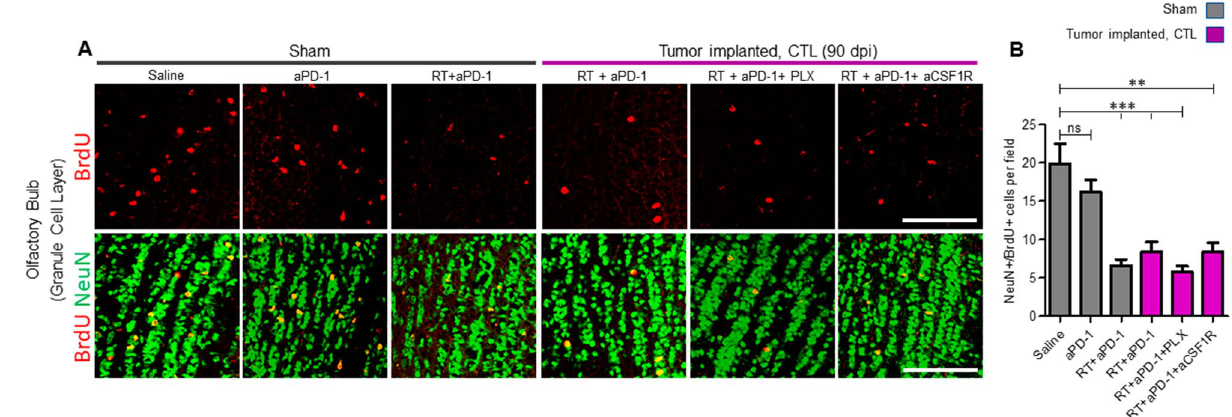
Figure 4. Treatment with RT + aPD-1 decreased the number of adult-born granule cells in the olfactory bulb. ( A ) Sham operated and tumor implanted mice received daily i.p. injections of BrdU starting at 60 dpi until 67 dpi. Coronal sections of the olfactory bulb (OB) from the hemisphere contralateral to the tumor implantation site (CTL) were collected at 90 dpi. Representative images from the granule cell layer (GCL) immunostained with antibodies against BrdU (red) and the neuronal marker NeuN (green) for the indicated experimental groups are shown. Scale bar = 100 µm. ( B ) Quantification of the number of adult-born granule cells (BrdU/ NeuN double positive cells) in the GCL of the OB. n = 3 per group, ** P < 0.01 and *** P < 0.01 by ANOVA followed by Tukey’s post hoc t test.